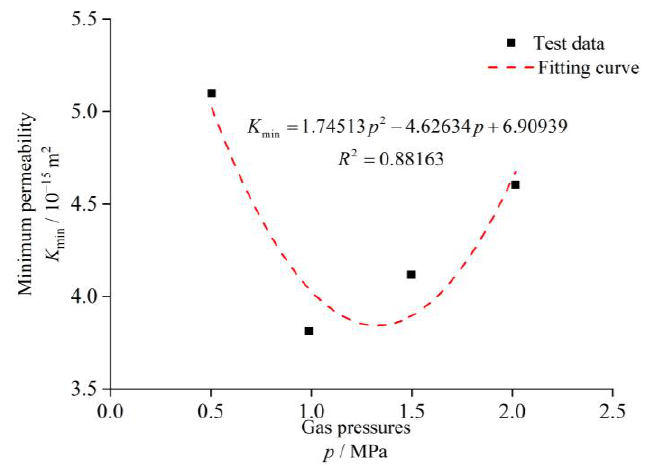
Figure 9. Variation curve of minimum permeability of coal sample under axial compression loading under a constant confining pressure of 4 MPa and different gas pressures.